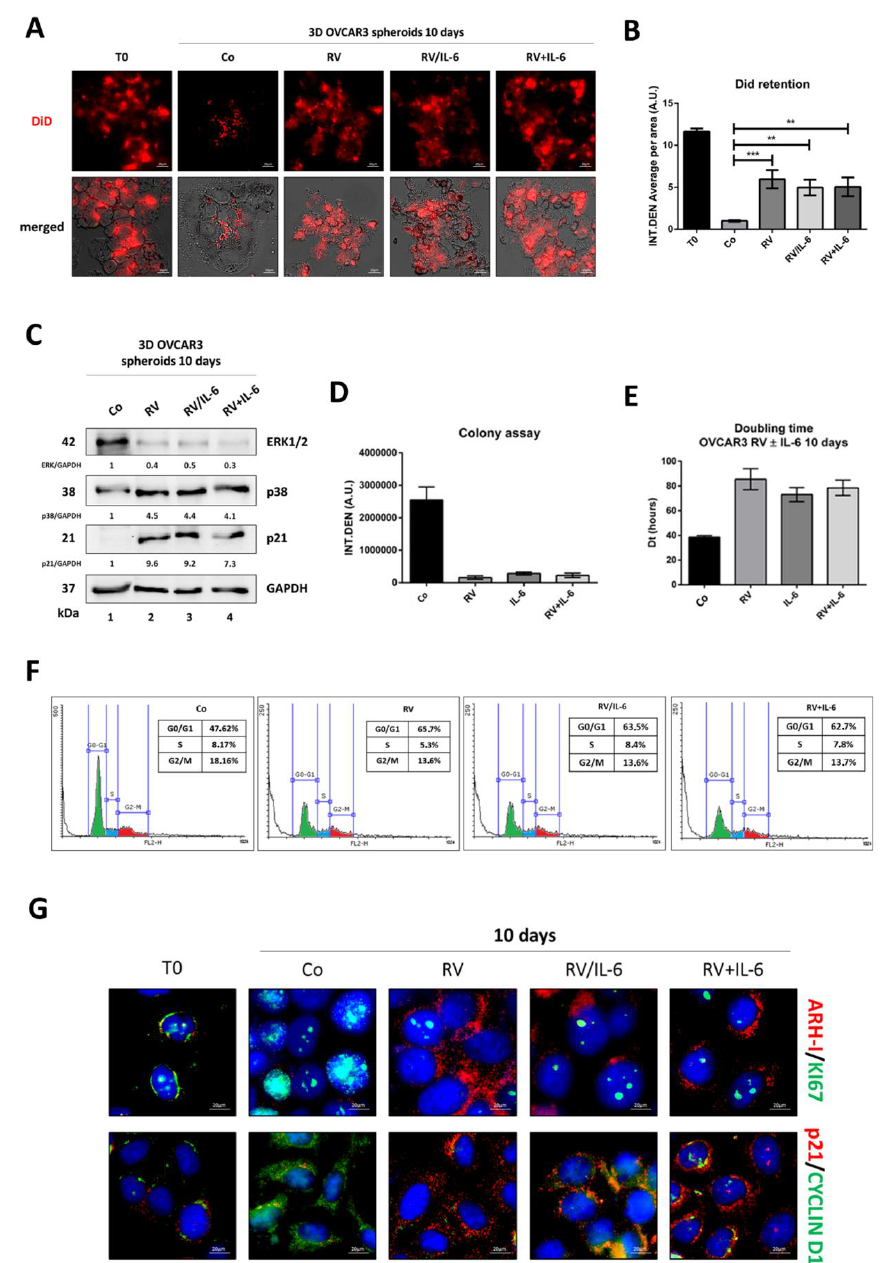
Figure 6. Resveratrol keeps 3D ovarian cancer spheroids in a dormant state. ( A – C ) OVCAR3 cells were grown as 3D spheroids and treated following the same timeline as Figure 5. A. Assessment of cell proliferation rate in OVCAR3 3D spheroids by DiD staining. Scale bar = 20 µm; magnification = 63×. ( B ) Quantification of DiD dye retention performed with ImageJ software. Data ± S.D. represent three independent replicates. Significance was considered as follows: *** p < 0.001; ** p < 0.01. ( C ) Western blotting for the expression of proliferation/quiescence markers (ERK1/2, p38, and p21) in 3D OVCAR3 spheroids collected on day 10. The densitometric analysis of Western blotting representative of three independent experiments is included. ( D – G ) OVCAR3 cells were cultured in 2D and treated as above. ( D ) Colony formation assay calculated on day 10. Data representative of three independent replicates. ( E ) Doubling time calculated on day 10. Data representative of three independent replicates. ( F ) Cell cycle analysis performed on day 5 and day 10 by using a FacScan flow cytometer. ( G ) Immunofluorescence double-staining performed on day 10 for ARH-I (red)–Ki-67 (green) and p21 (red)–cyclin D1 (green). Scale bar = 20 µ m; magnification = 63